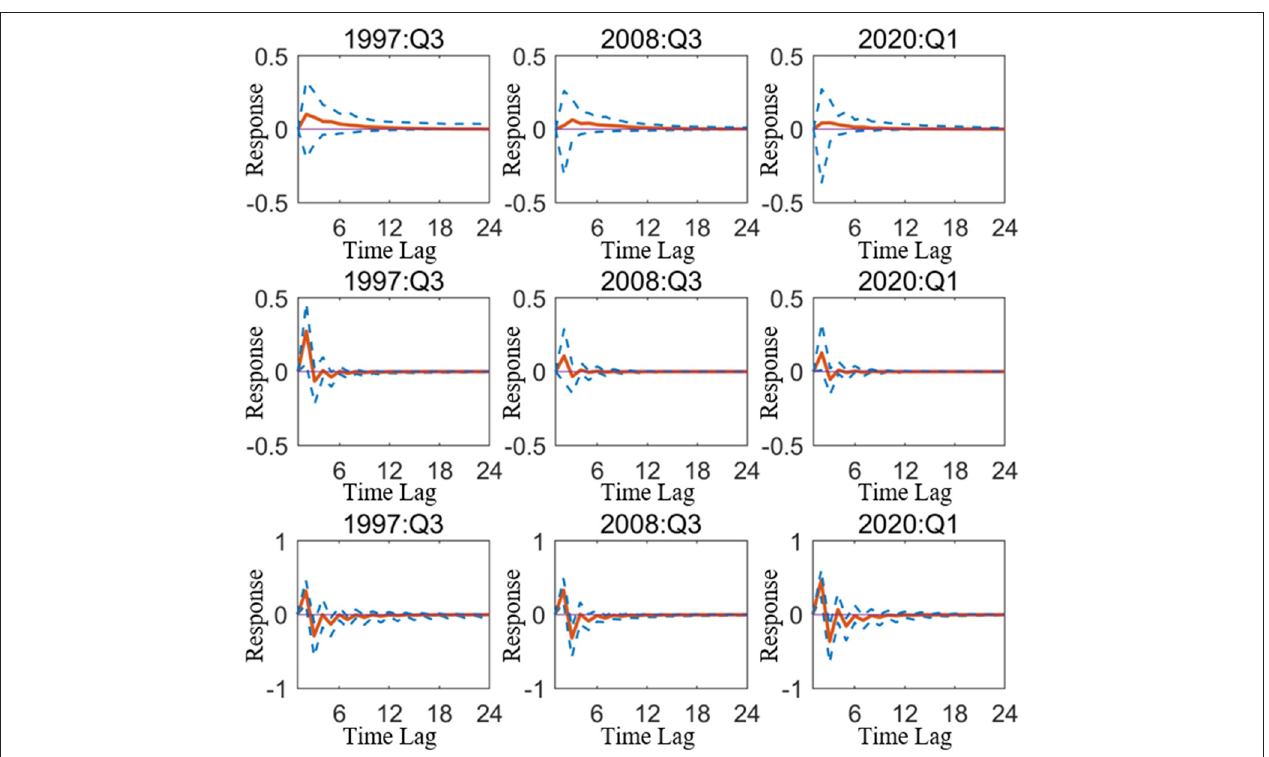
FIGURE 4 | Impulse response of quantitative monetary policy acting on mainland China in particular period. The three sub graphs represent the impulse responses of the primary, secondary, and tertiary industries from top to bottom, respectively. One period in the figure denotes one